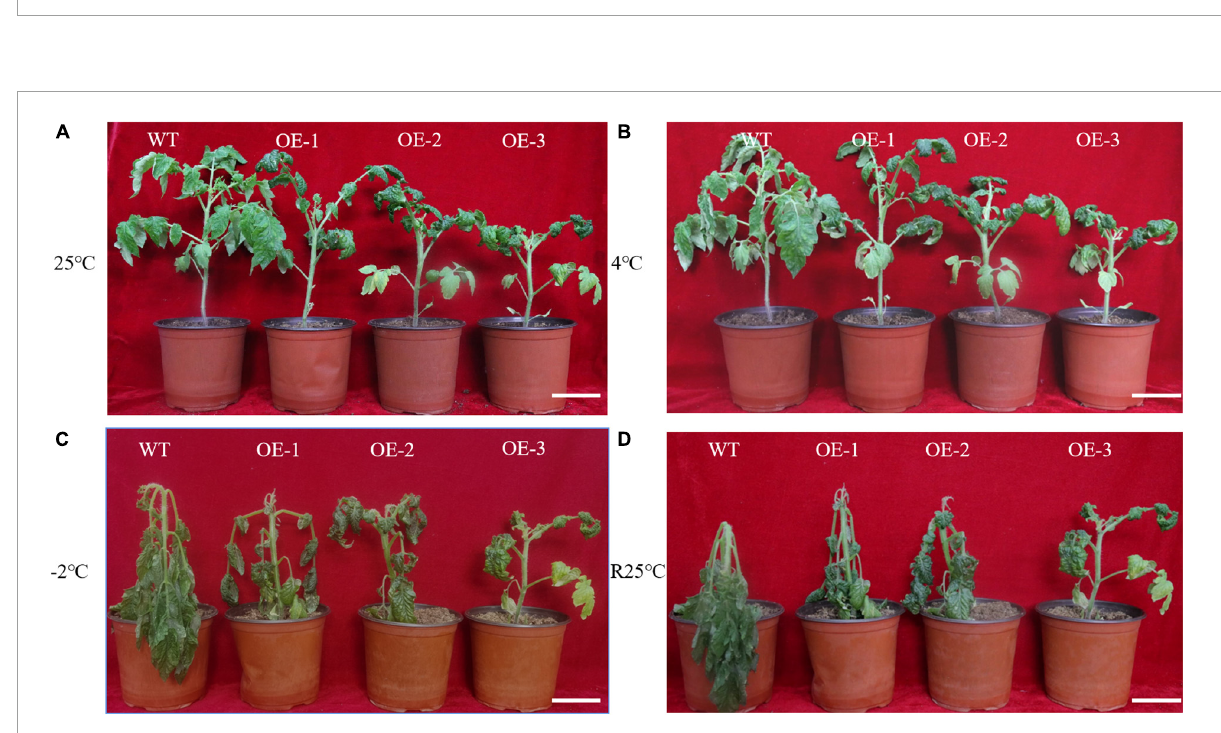
FIGURE4 Phenotypes of wild-type and SiLEA4 -overexpressing transgenic tomato plant under cold stress. (A) Wild-type and transgenic tomatoes were grown in a greenhouse at 25 ◦ C for 5 weeks of age. (B) Growth status of tomato plants incubated in a low temperature incubator at 4 ◦ C for 6 h. (C) Morphological differences between transgenic and wild-type tomato plants incubated at –2 ◦ C for 4 h. (D) Morphological differences between transgenic plants and wild-type plants 1 day after recovery from low temperature stress at 25 ◦ C. Bar = 7